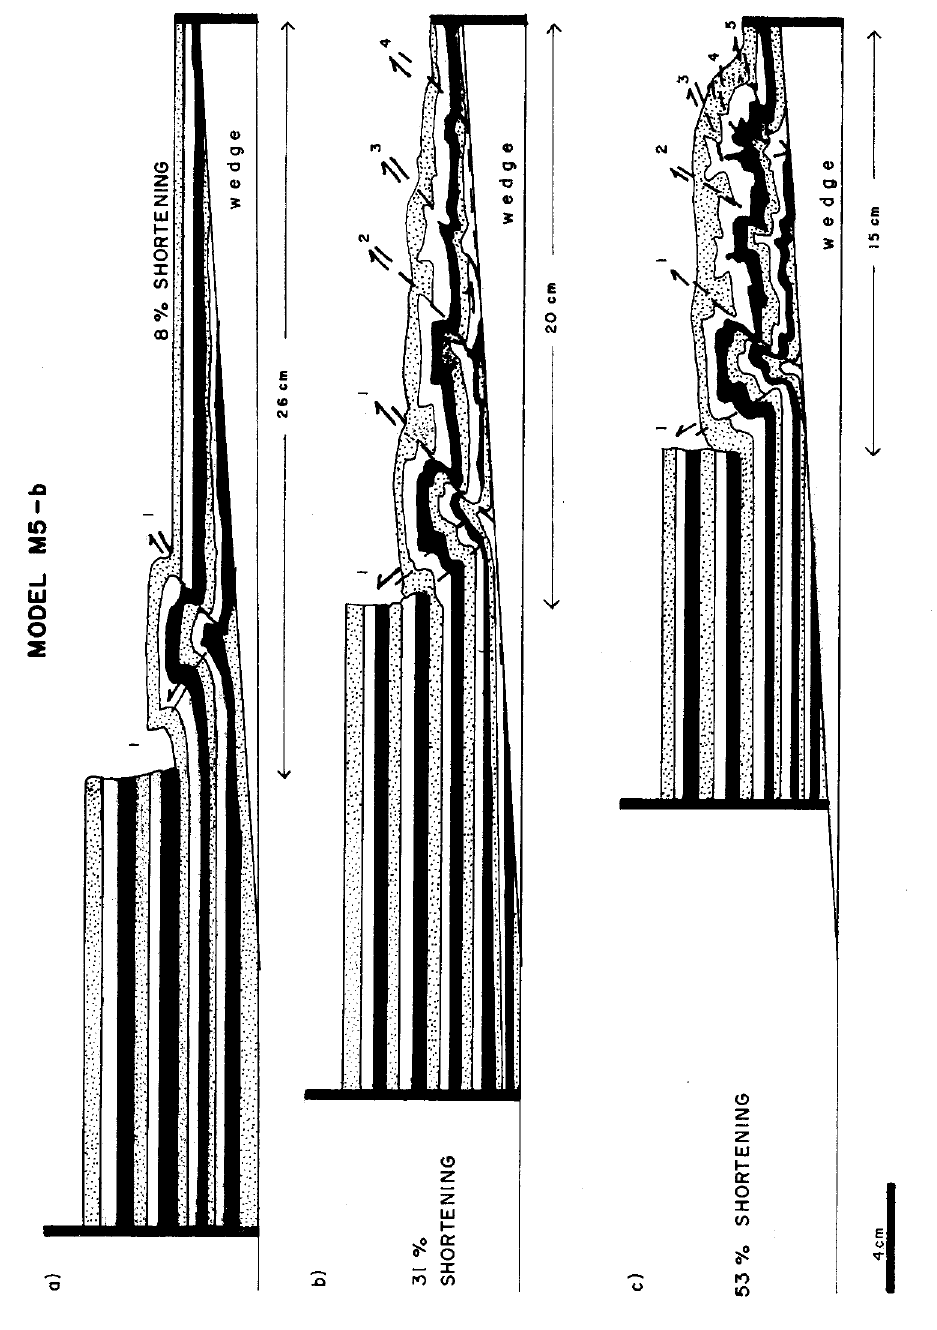
Fig. 15 – Model M5-b with a 5 ◦ inclined wooden wedge in the foreland and deformable backstop. (a) After 8% shortening; (b) after 31% shortening, a thrust system similar to model M5-a formed. (b) After 53% shortening, an antiformal stack develops in the